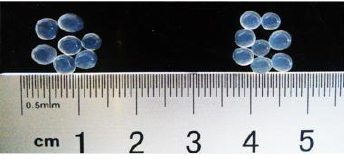
Figure 1. Morphology of both vacant beads (left) and HG10 beads (right) prepared from sodium